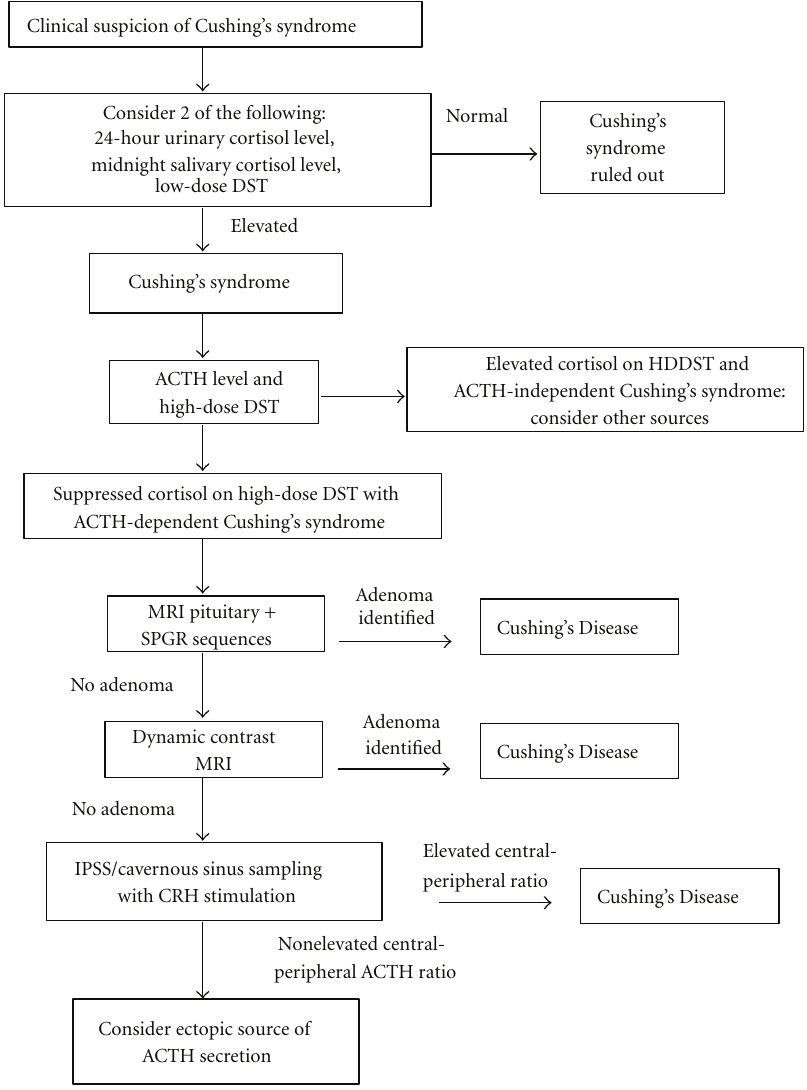
Figure 1: A stepwise algorithm for the diagnosis of Cushing’s Disease. (Abbreviations: ACTH: adrenocorticotropic hormone, DST: dexamethasone suppression test, MRI: magnetic resonance imaging, SPGR: spoiled gradient recall, CRH: corticotropin-releasing hormone, IPSS: inferior petrosal sinus